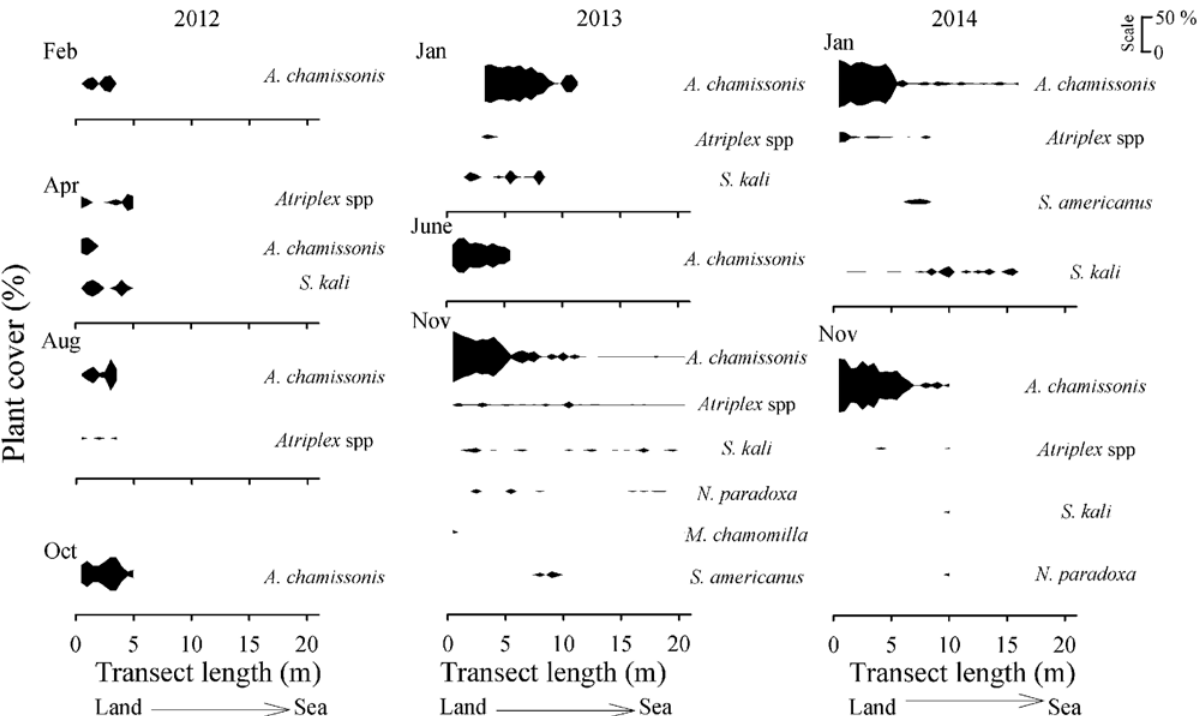
Fig 7. Across-shore distribution (m) over time of the dune plant species (plant cover in %). Sandy beach site located in front of the rocky revetment at Llico (scale: 0 – 50%). Upper-shore levels started at 0 m. The sampling times were: February, April, August, October 2012 January, June, November 2013, and January, November